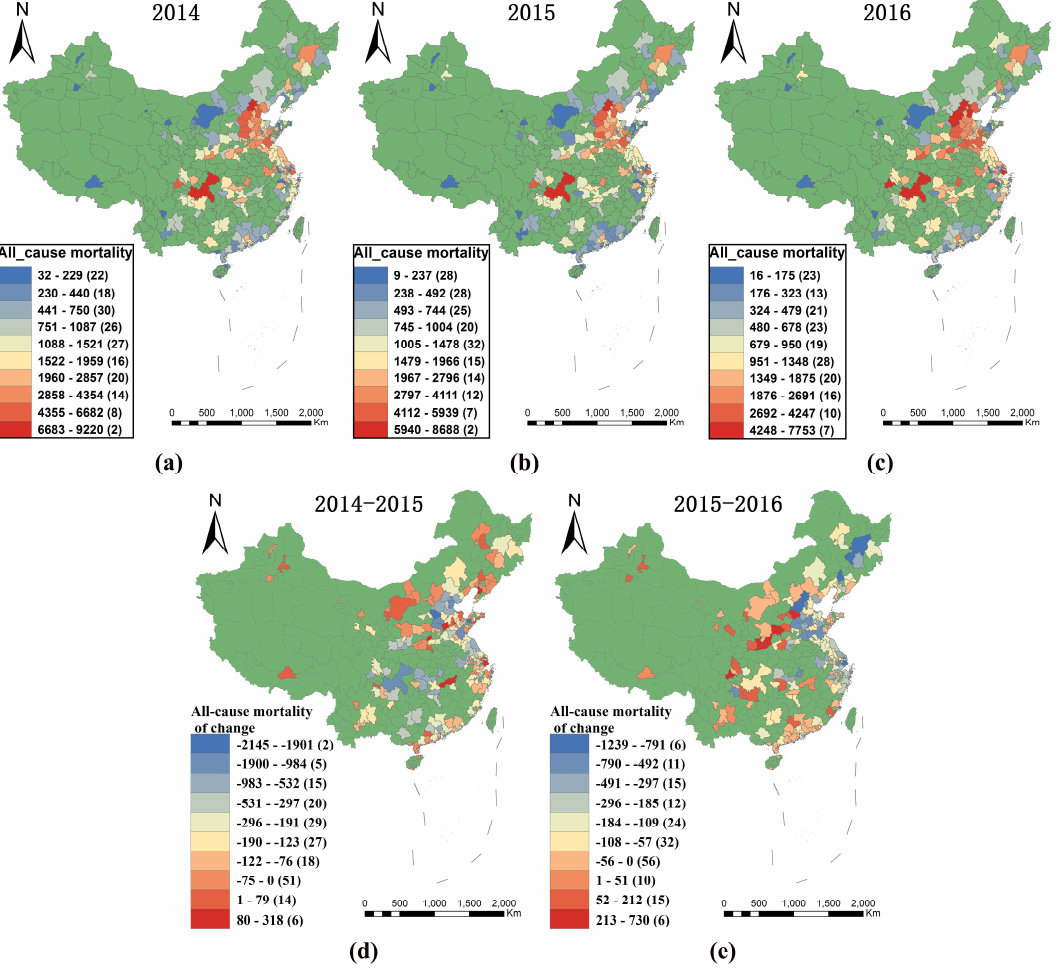
Figure 3. Spatial distribution of PM 2.5 -related health impacts (all-cause mortality) in 2014 ( a ); 2015 ( b ); and 2016 ( c ). Distribution of changes in PM 2.5 -related health impacts (all-cause mortality) for the periods 2014–2015 ( d ) and 2015–2016 ( e ).